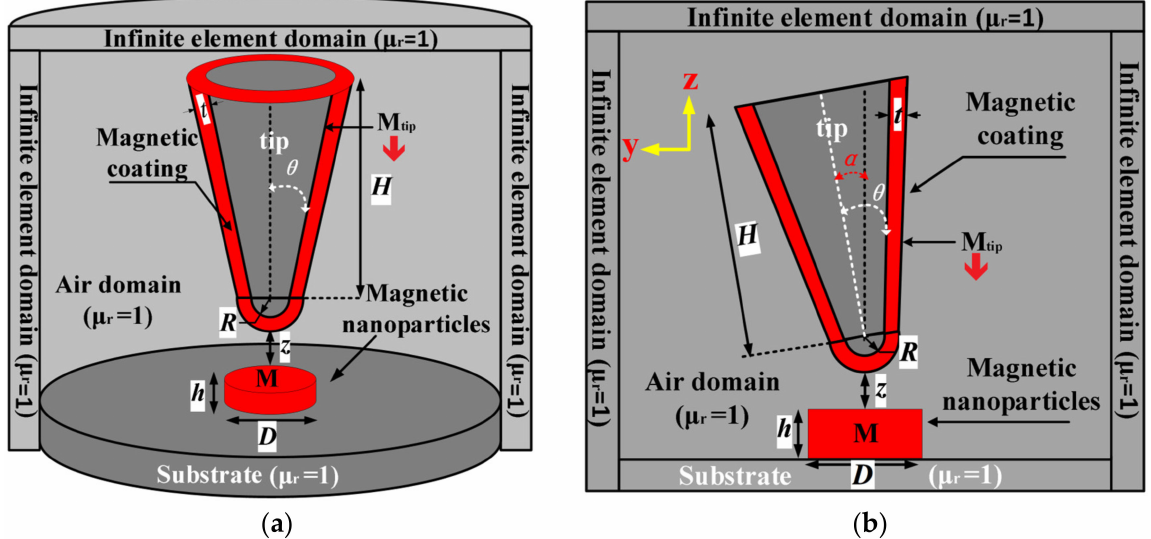
Figure 2. Schematic 3D model of magnetic force probe system: ( a ) vertical probe; and ( b ) tilt probe. H —truncated cone height; R —tip curvature radius; D —sample diameter; z —vertical distance from probe tip to sample surface; h —sample thickness; θ —probe cone half-angle; α —probe tilting angle; t —permanent magnetic coat thickness on probe